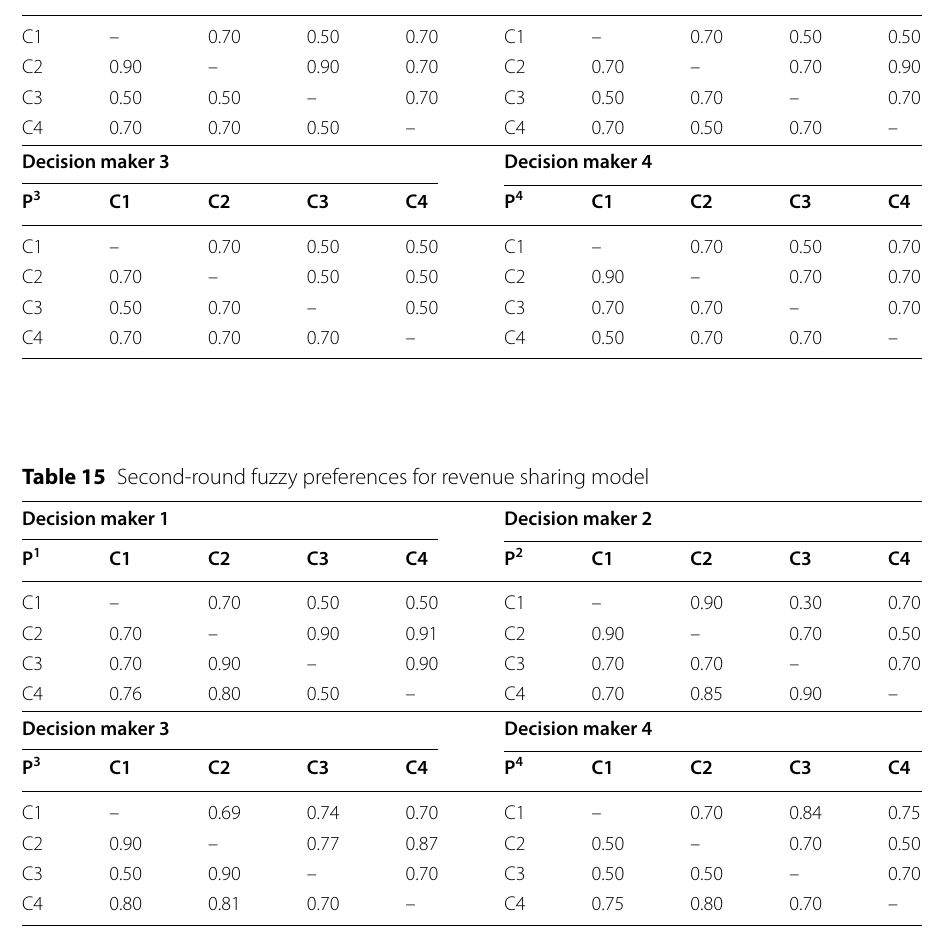
Table 14 Consensus-based fuzzy preference relations for rewarding model Decision maker 1